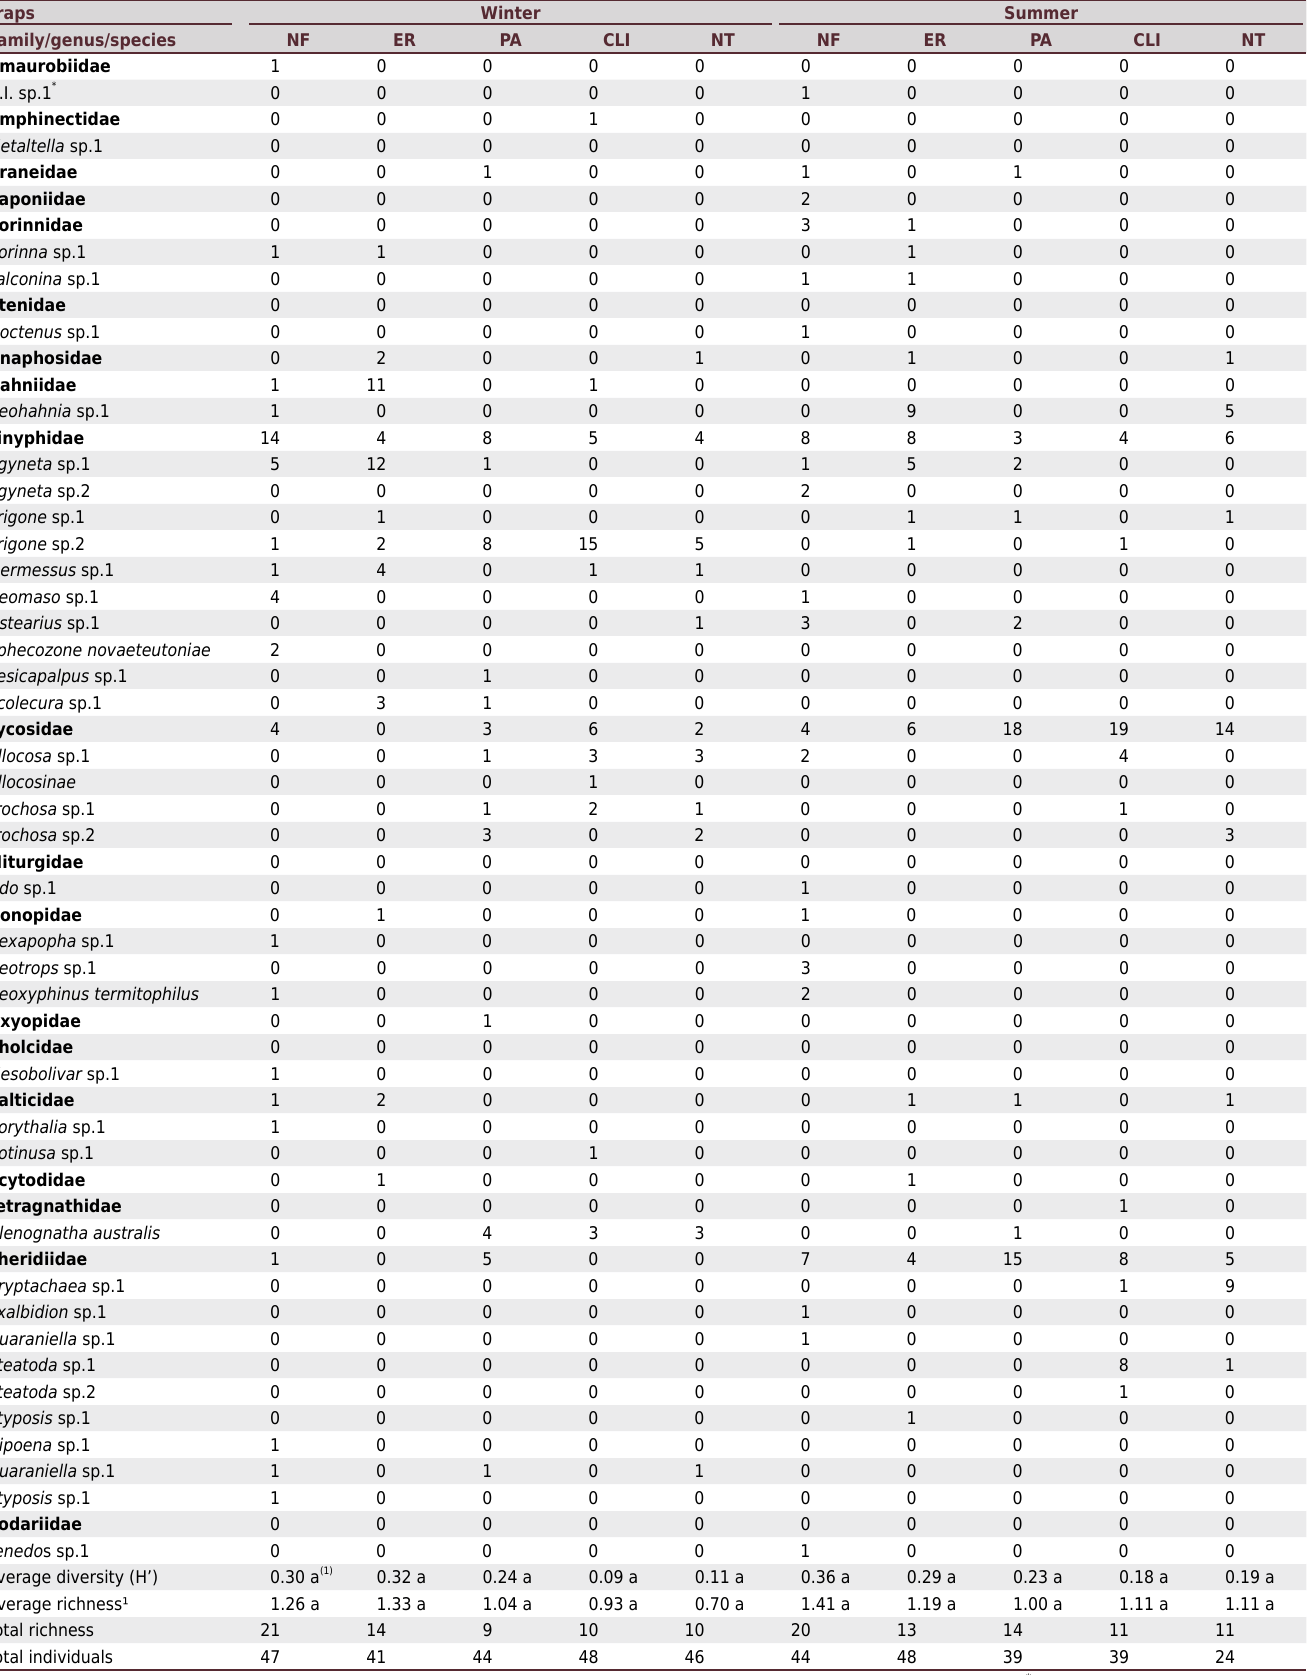
Table 4. Total number of individuals (spider families) caught in western Santa Catarina in soil traps in two contrasting seasons (winter and summer) in native forest (NF), eucalyptus reforestation (ER), pasture (PA), crop-livestock integration (CLI), and no-tillage annual crops (NT) Traps Winter Summer Family/genus/species NF